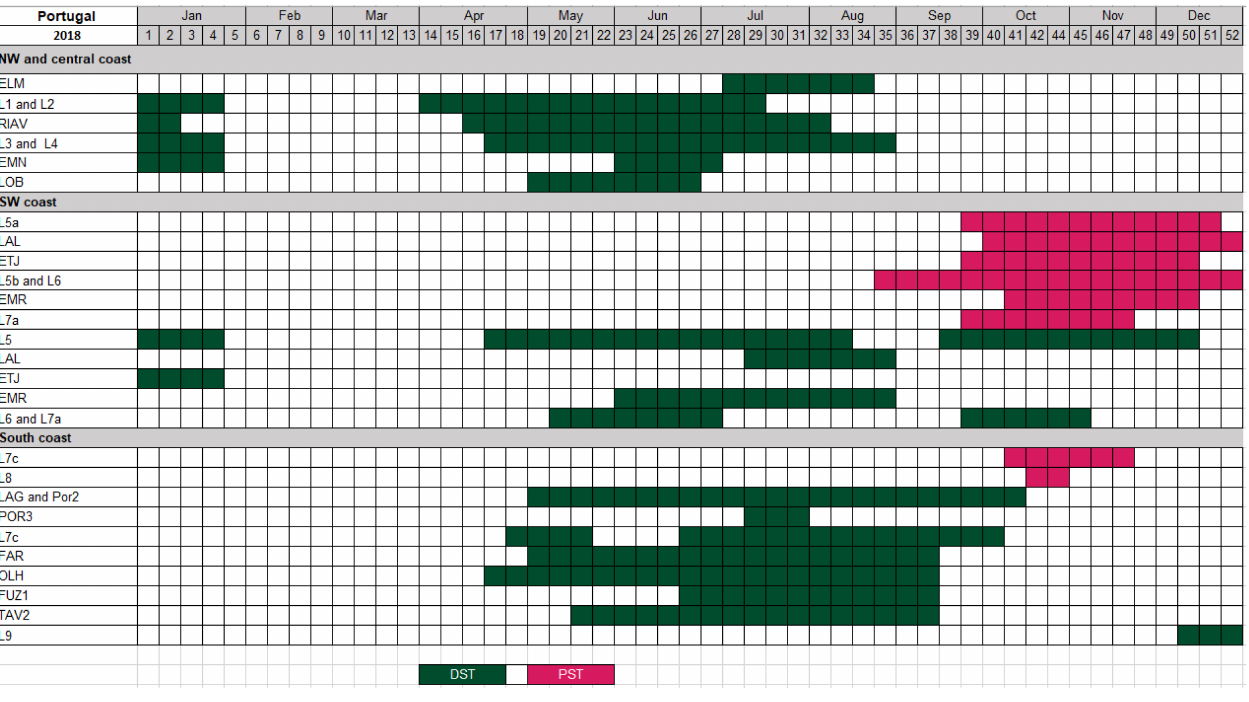
Frontiers in Marine Science |